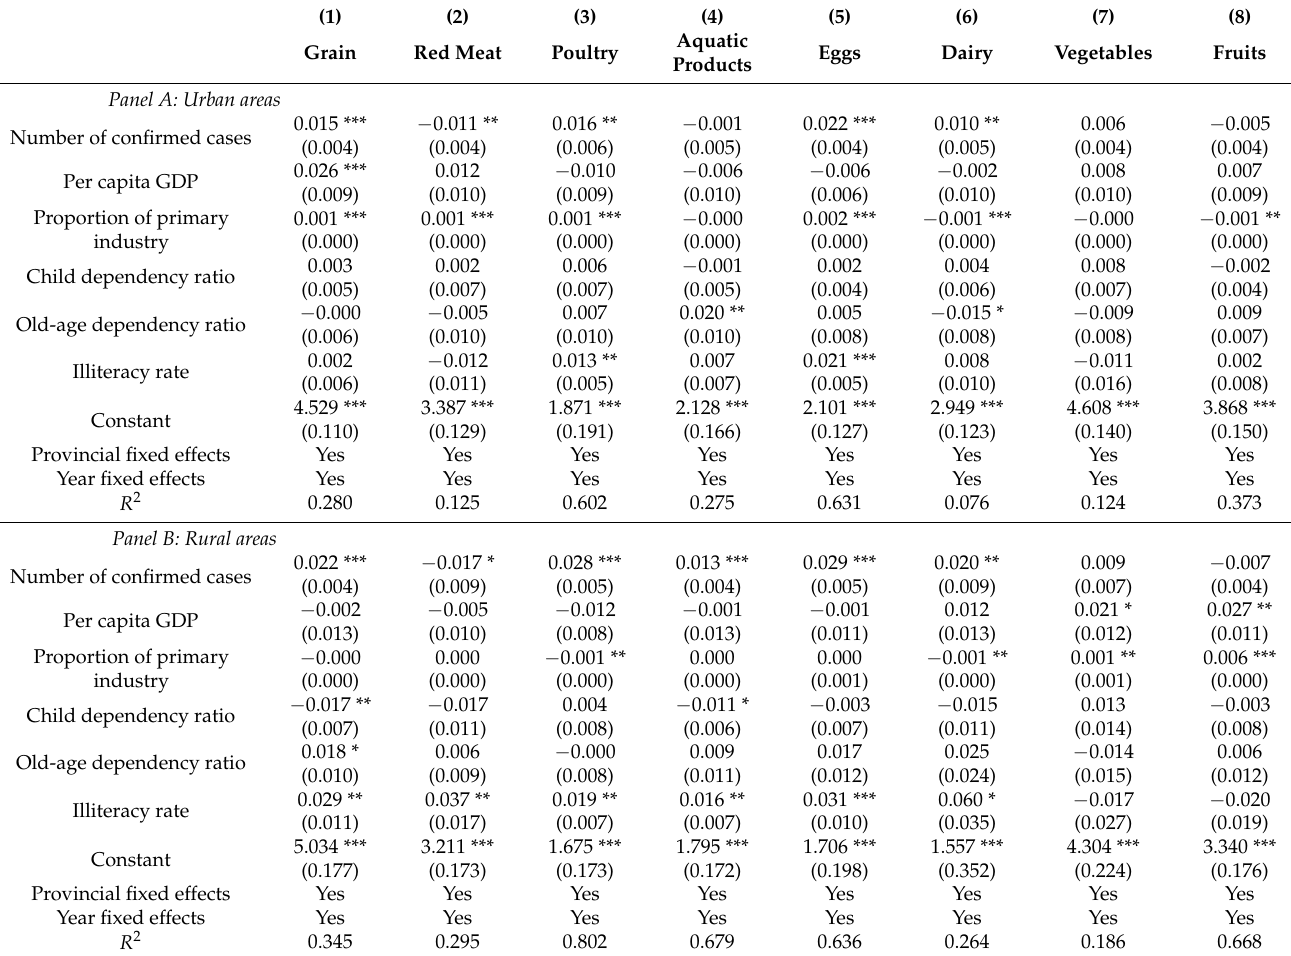
Table 2. Impacts of COVID-19 on urban and rural dietary